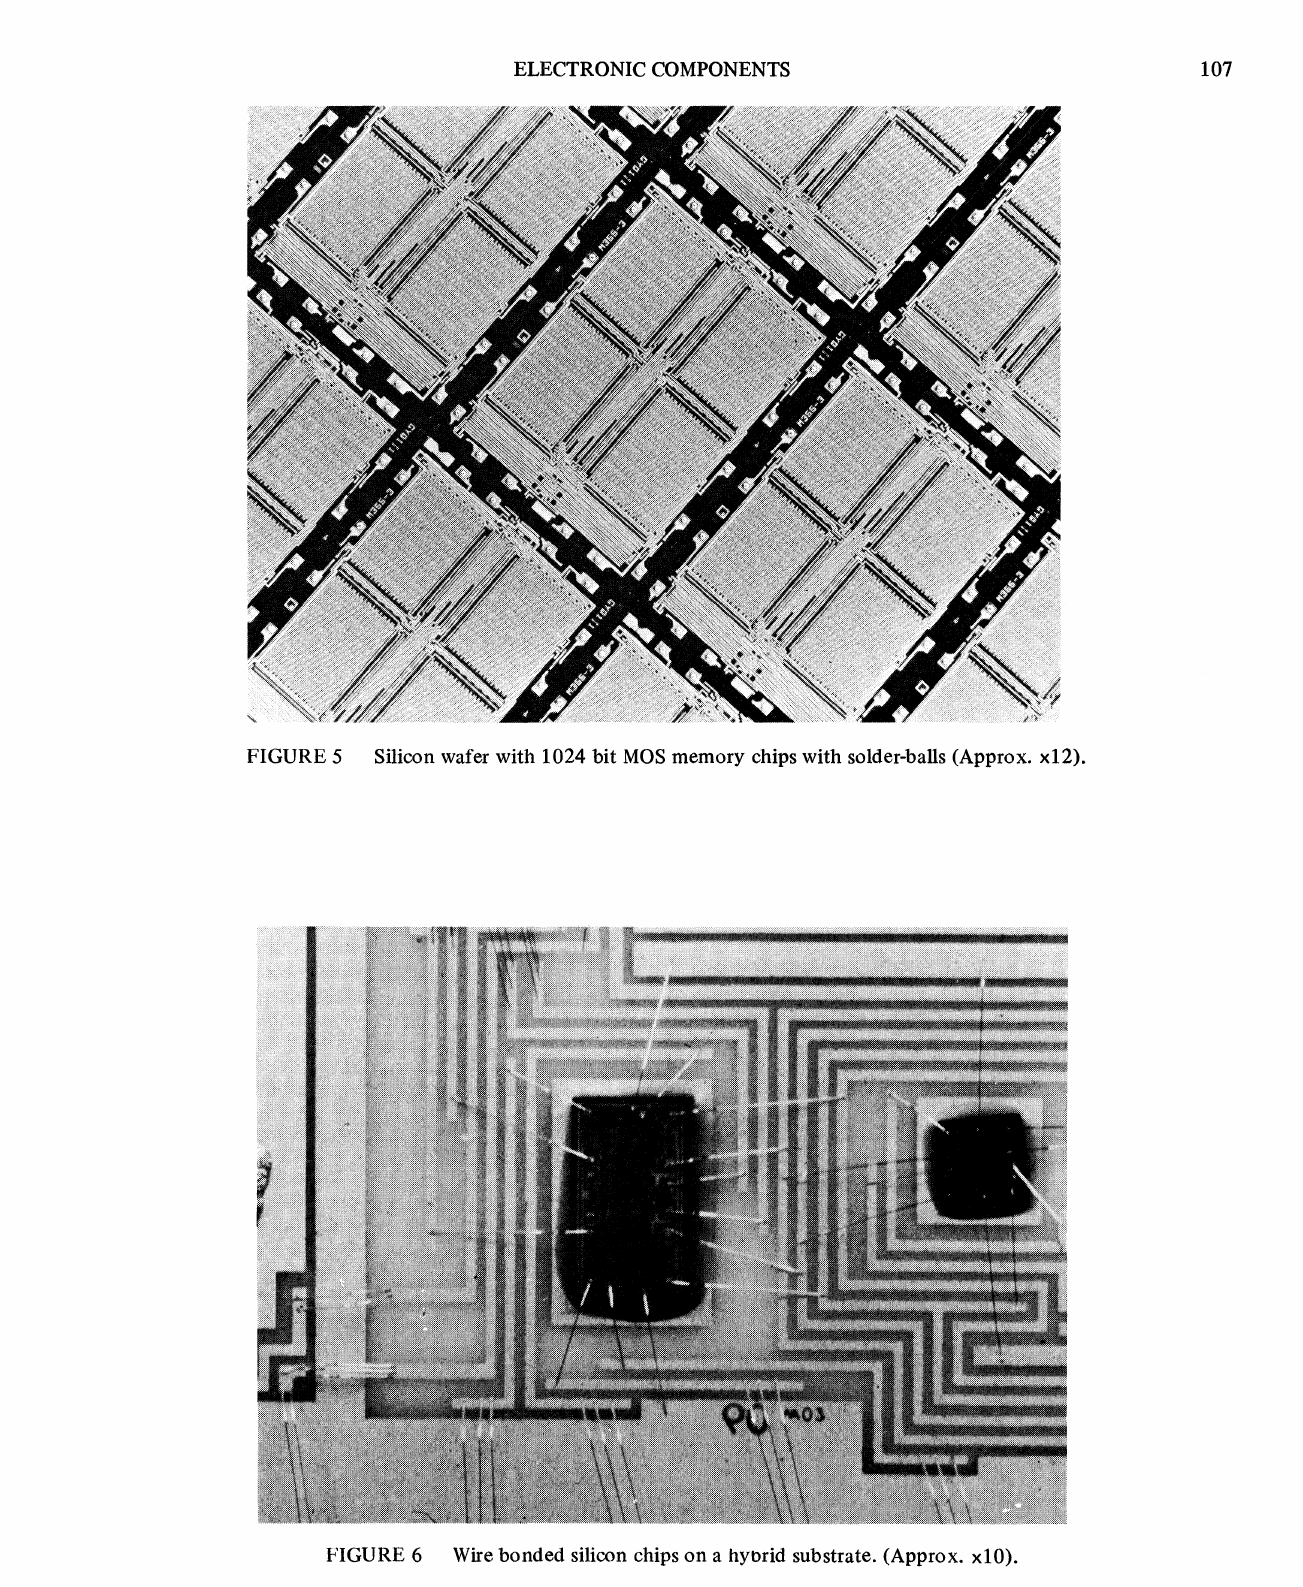
FIGURE 6 Wire bonded silicon chips on a hytrid substrate. (Approx.